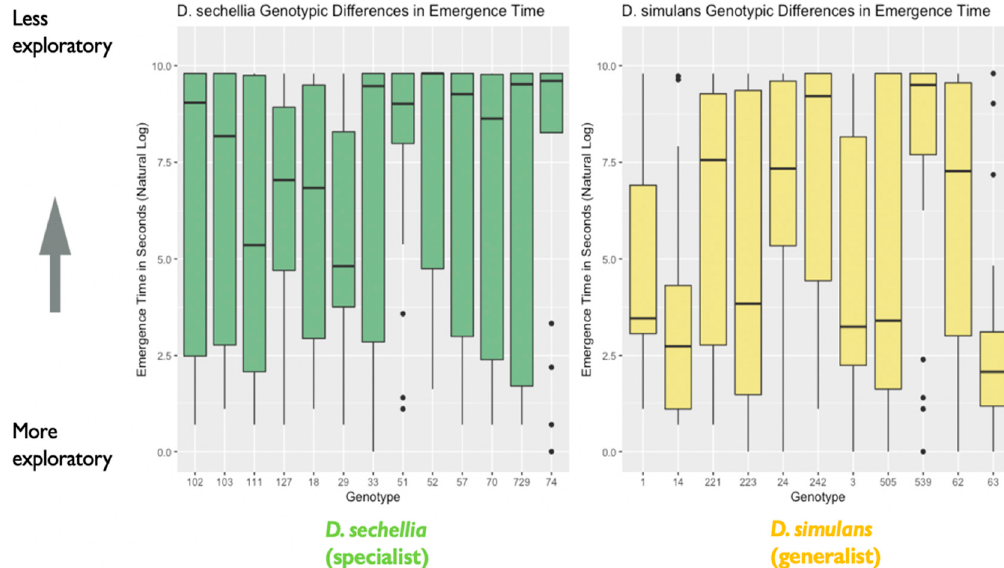
Figure 3. Genotypic di ff erences in emergence time (in seconds): the plot represents genotypic di ff erences in emergence time (in seconds), as noted in the main text. Data are from the first experiment measuring exploratory behavior. The y-axis represents the natural log of emergence time in seconds. A lower emergence time indicates higher exploratory behavior, while a higher emergence time represents lower exploratory behavior ( n = 526 flies). The box in the plot represents the inter-quartile range of scores, including the middle 50% of scores for the group, with the median score represented by the middle quartile mark (or line). The whiskers represent the score ranges outside the inter-quartile range, including the top 25% of scores for the group in the upper whisker, and the bottom 25% of scores in the lower whisker. Our findings indicated significant genotypic di ff erences in exploratory behavior.